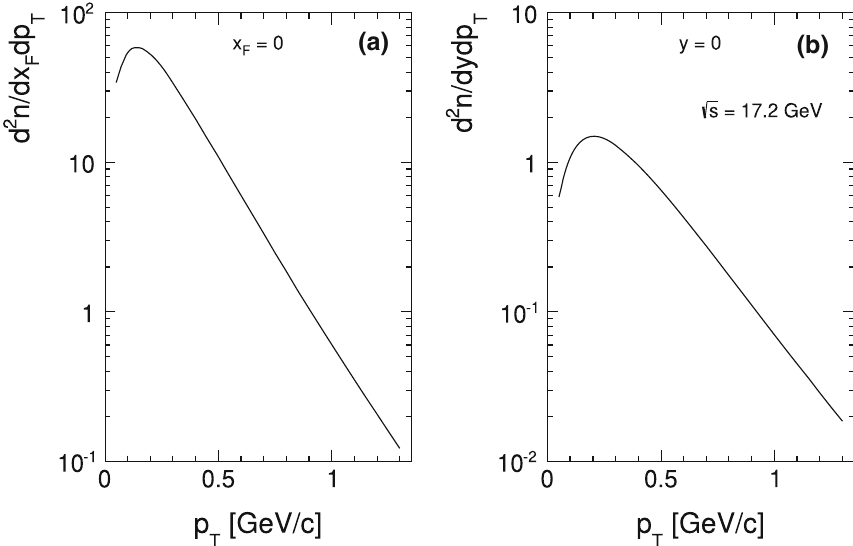
Fig. 138 a Pion densities d 2 n / dx F dp T for x F = 0 and b d 2 n / dydp T for y = 0 as a function of p T at √ s = 17.2 GeV/c